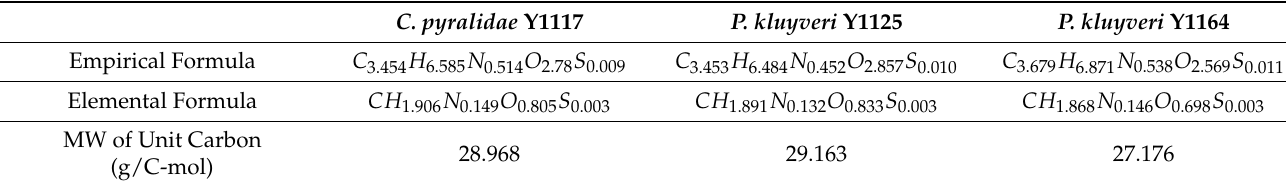
Table 4. Empirical, elemental formula and molecular weight of unit carbon mole of C. pyralidae Y1117, P. kluyveri Y1125, and P. kluyveri Y1164 during yeast growth and secondary metabolite production, i.e., biopreservatives using grape pomace extract as a fermentation